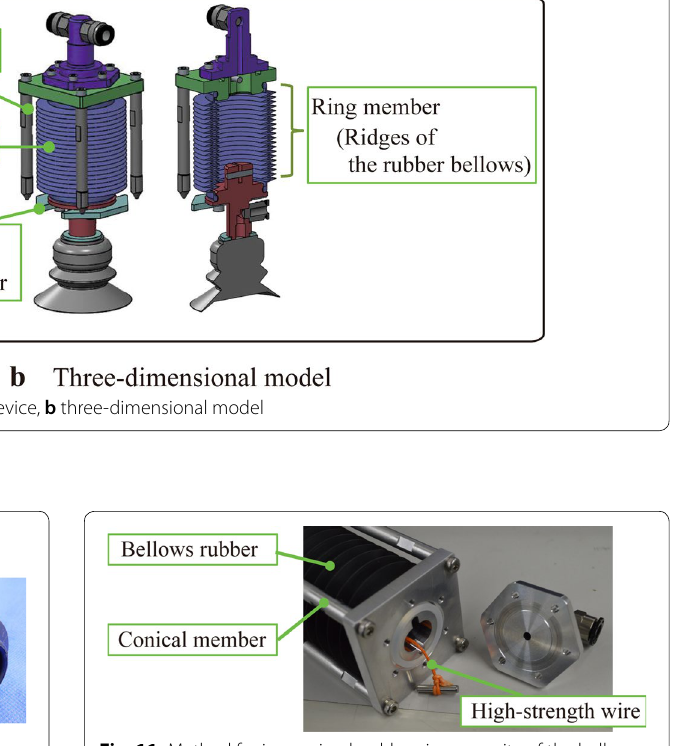
length 45 mm, maximum length 140 mm). To improve (Fig. 11). Ultra Dyneema 30 (strength 120 kg) fishing line was adopted as the high-strength wire. The rela- tional expression in Eq. (1) was established between the